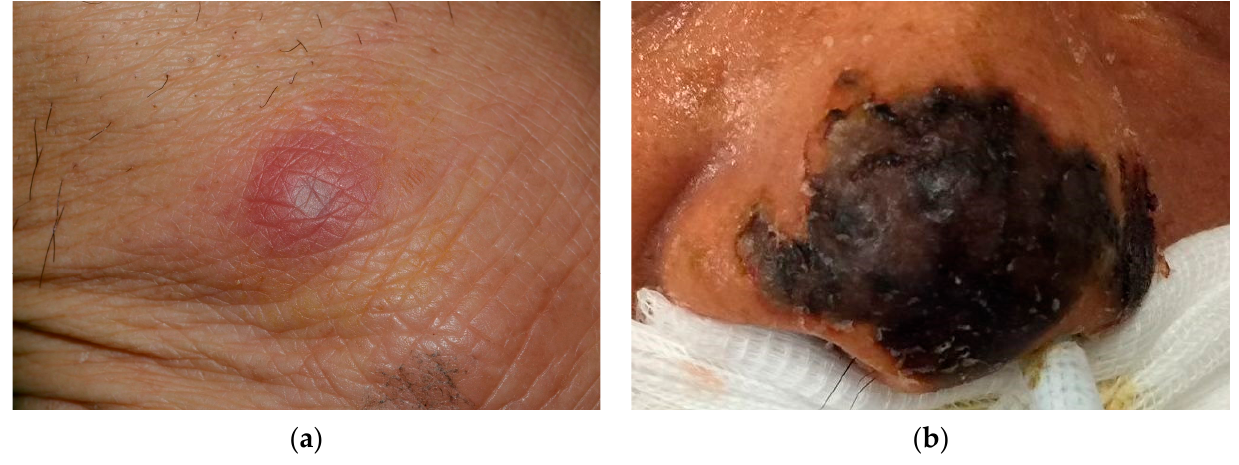
Figure 2. Skin lesions of systemic mycoses: ( a ) erythematous papules on the ankle and four limbs (unknown pathogen); and ( b ) necrotic plaques on the nose tip ( Candida albicans ).